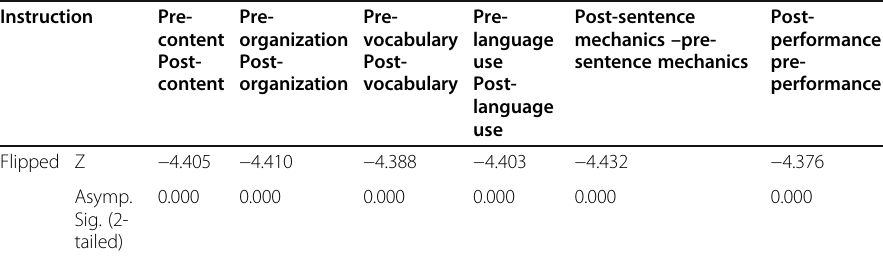
Table 2 Wilcoxon signed-rank test